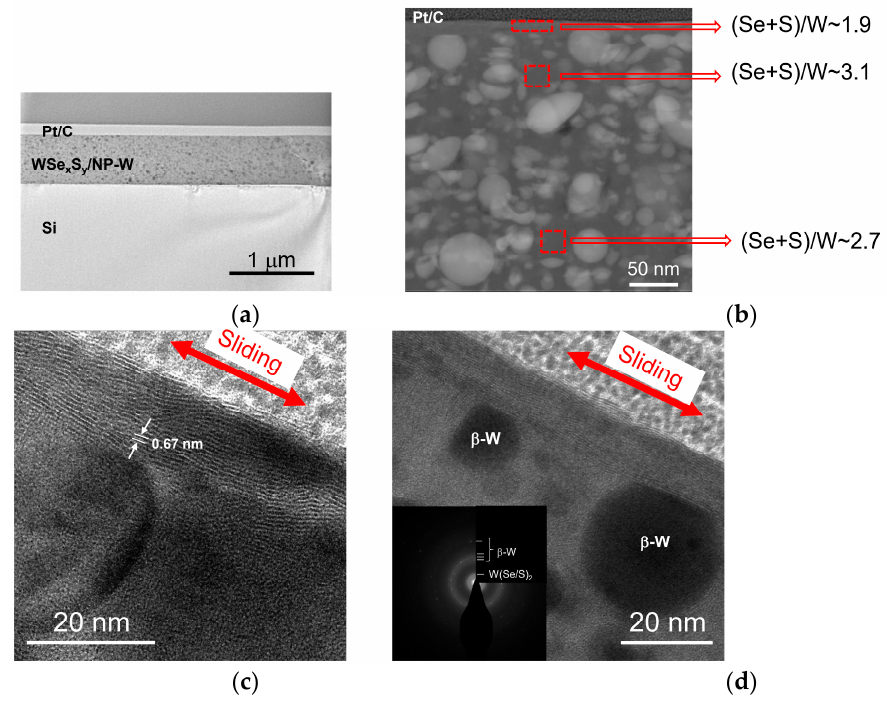
Figure 13. Cross-section STEM и SAED patterns of the WSe x S y /NP-W_3.6 coating subjected to tribotesting (~1000 cycles) in N 2 -enriched environment at 5 N load on the counter body: ( a ) low-magnification TEM image of the coating; ( b ) HAADF STEM image of the coating and EDS data of the local area composition; and HRTEM images exhibit ( c ) the layered tribofilm formation and ( d ) the wear of nanoparticles on the surface. The insert in ( d ) contains the SAED pattern for the surface layer.